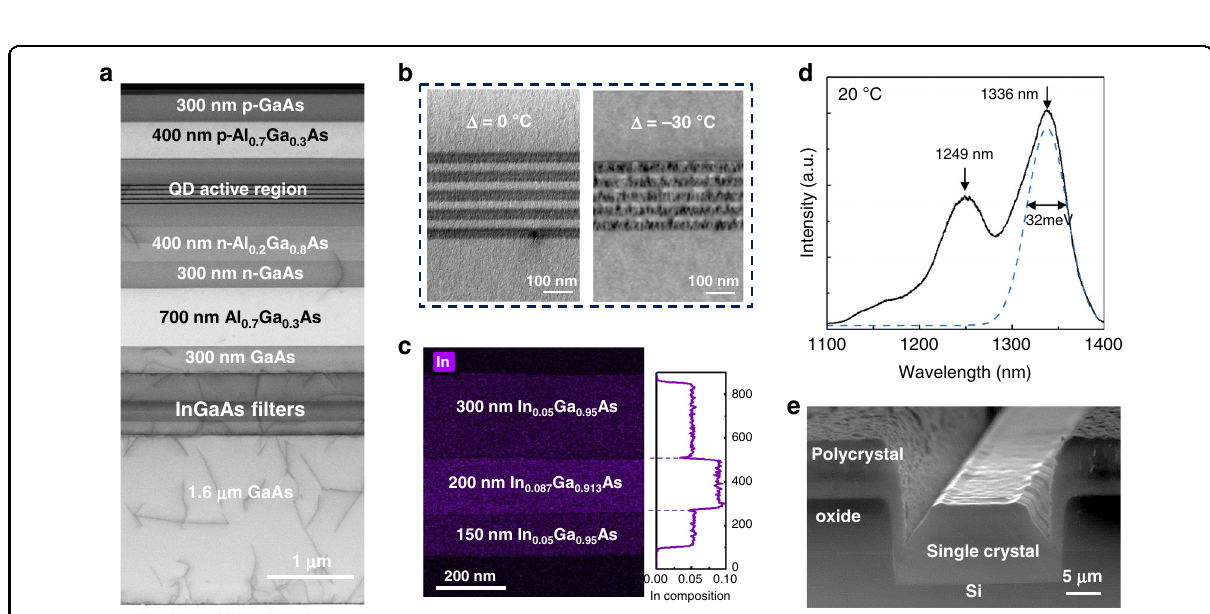
Fig. 3 Characterization of the as-grown in-pocket material. a Cross-section TEM of the full in-pocket III – V stack above the 200 nm GaP. b Cross- sectional STEM of the active region with different temperature adjustments. Clear QD contrast observed after 30 °C decrease (right). c EDS map of the dislocation fi lter layers labeled with the designed compositions (left) and the extracted actual composition (right). d Room-temperature PL spectrum from the in-pocket laser material, the dashes line is the Gaussian fi t of the ground state line shape. e Cross-section SEM of the as-grown in-pocket